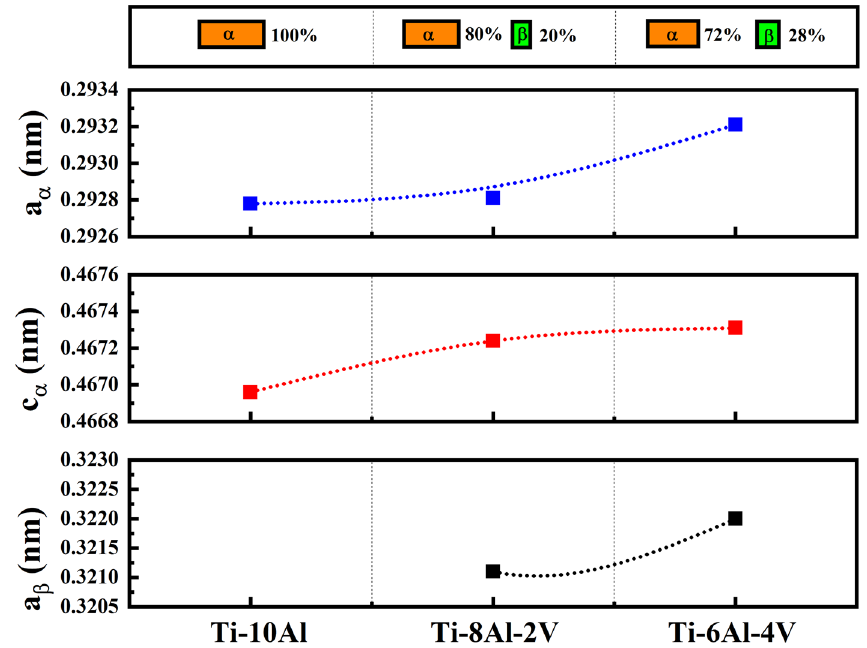
Figure 3. Phase composition and cell parameters.